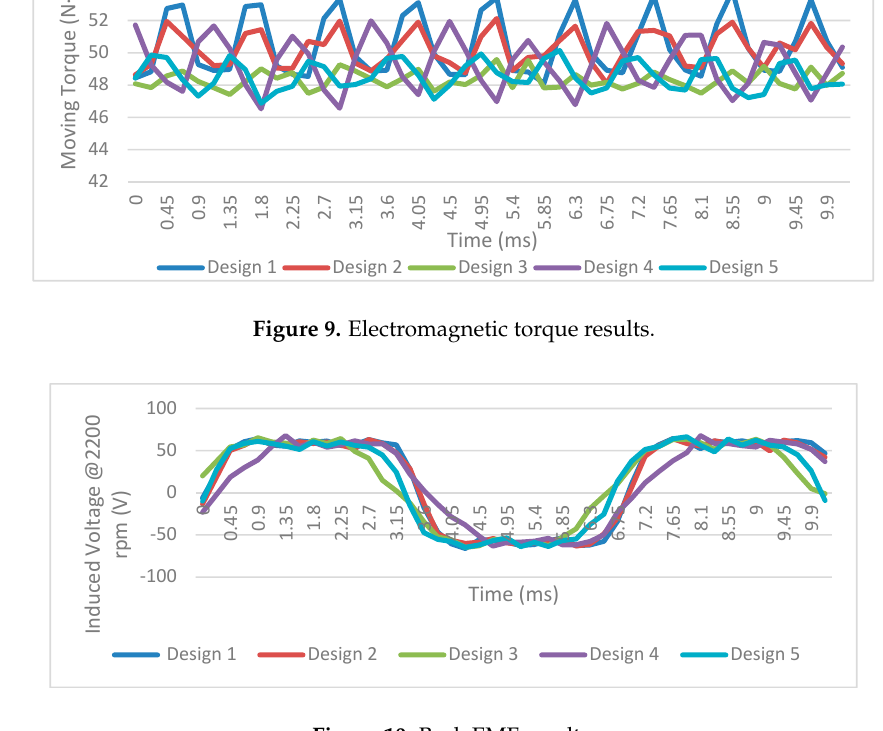
Design V Figure 11. Flux density distributions for ¼ machine (for 90 mechanical degrees).